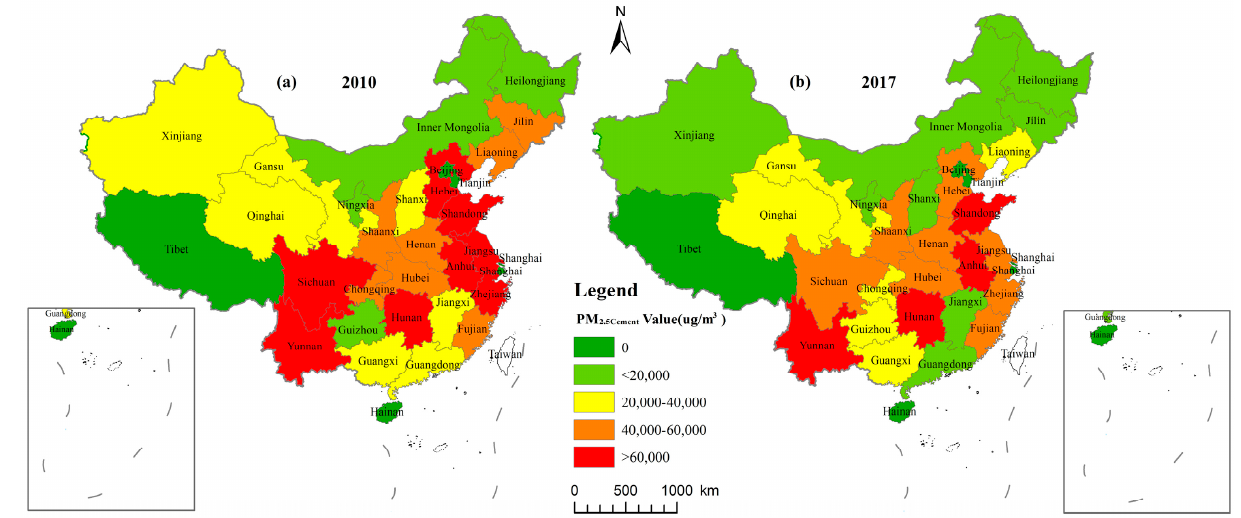
Figure 1. Spatial distribution of the annual PM 2.5Cement in 2010 and 2017.